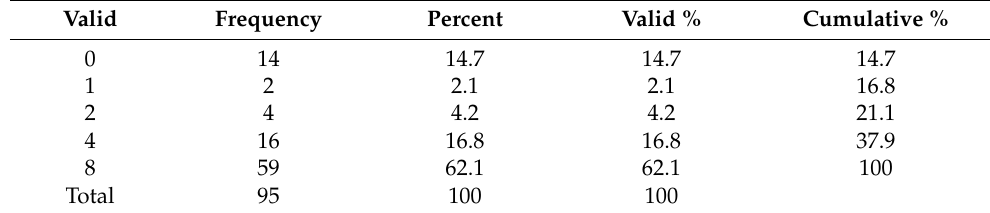
Table 3. Response products.